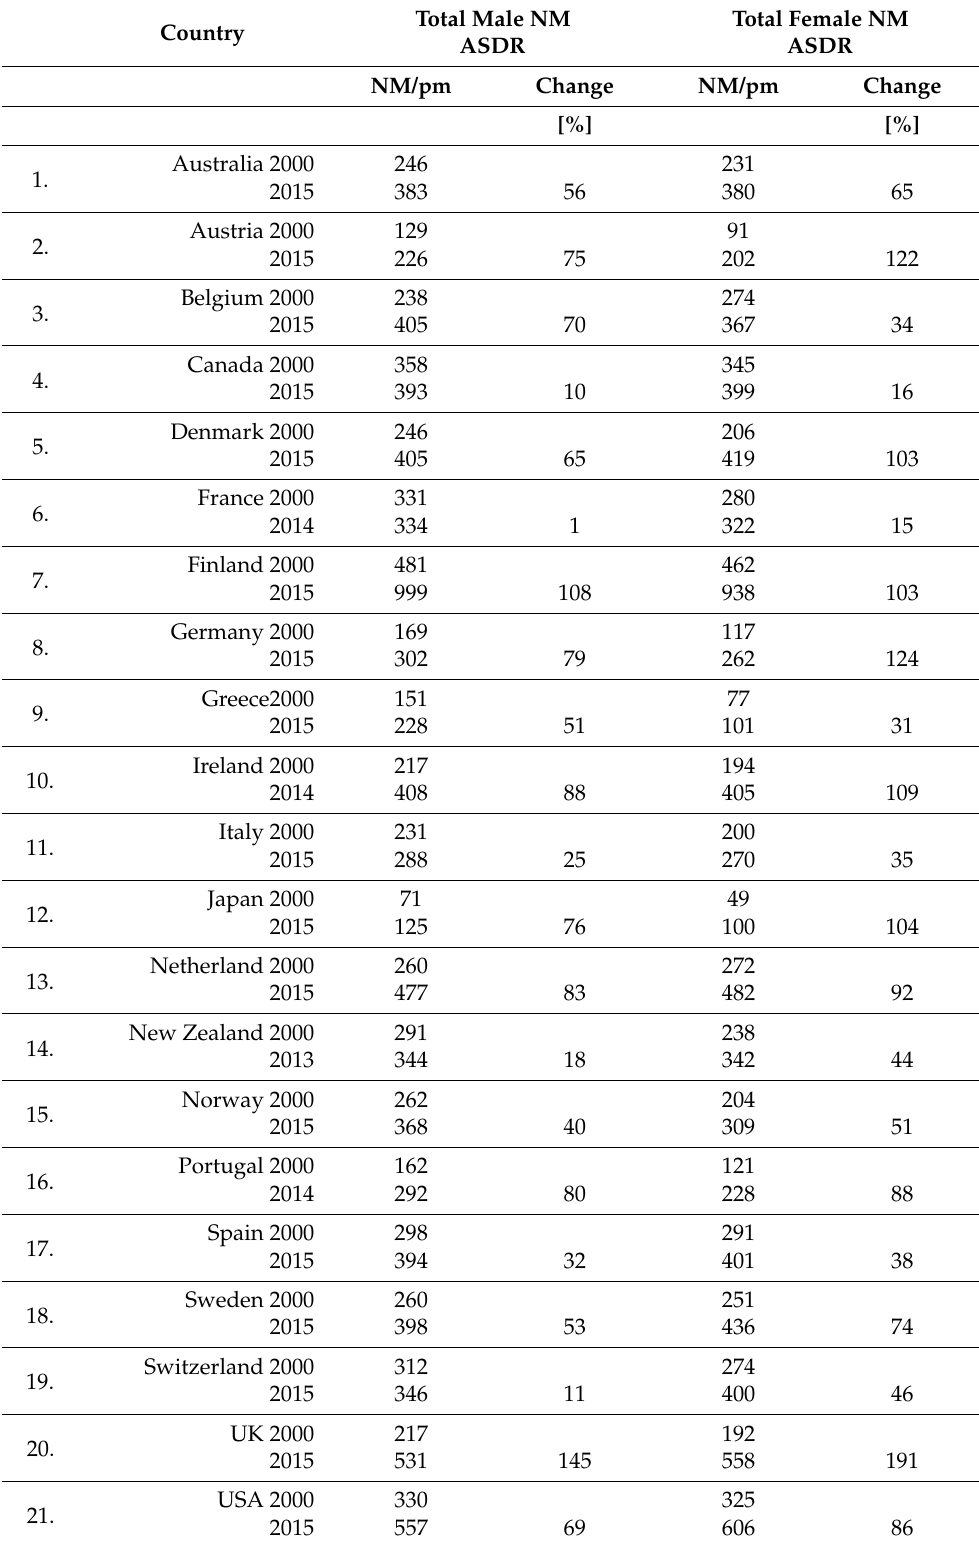
Table 2. Male and female combined neurological mortality (NM) in Age-Standardised Death Rates (ASDR), split by sex rates per million (pm) in selected developed countries. Based upon WHO [26] data. Total Male NM Total Female NM Country ASDR ASDR NM/pm Change